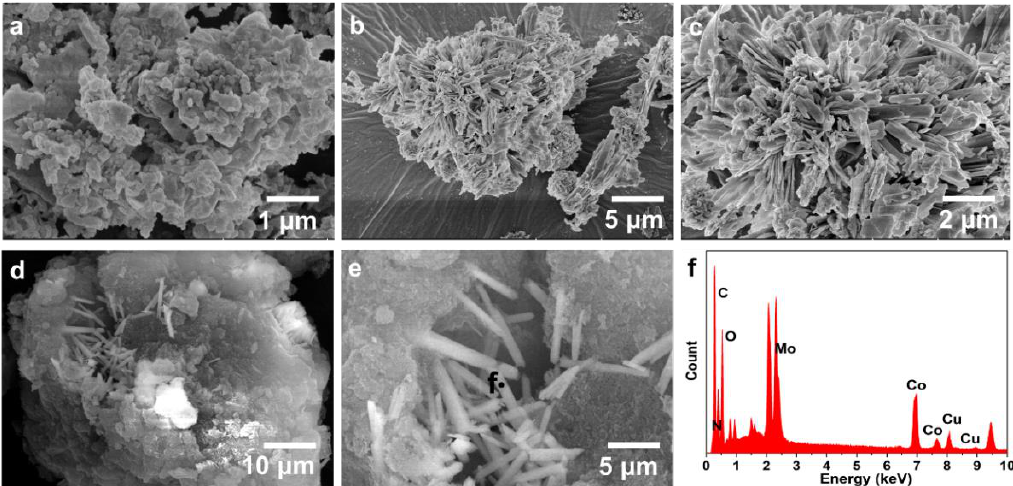
Figure 3. FESEM images of ( a ) g-C 3 N 4 , ( b,c ) Cu 0.4 Co 0.6 MoO 4 , and ( d,e ) Cu 0.4 Co 0.6 MoO 4 / g-C 3 N 4 ; ( f ) EDS spectrum of point analysis.